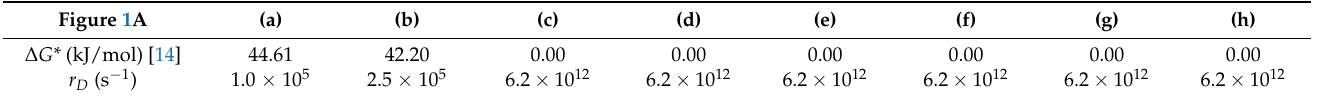
Table 1. Atomistic activation energy ( ∆ G *) [14] and the calculated atomistic forward reaction rates ( r D ) (using Equation (1)) for the Ca-C1 dissolution on the (100) and (100) facets for 8 different event scenarios applied in case 1. Ca-C1 dissolution (Figure 1A): (a) in the presence of Ca1, Ca2, Ca3, and Ca4; (b) in the presence of Ca2, Ca3, and Ca4; (c) in the presence of Ca2 and Ca4; (d) in the presence of Ca2 and Ca3; (e) in the presence of Ca1 and Ca3; (f) in the presence of Ca3; (g) in the presence of Ca2; and (h) in the absence of all 4 Ca neighbors.